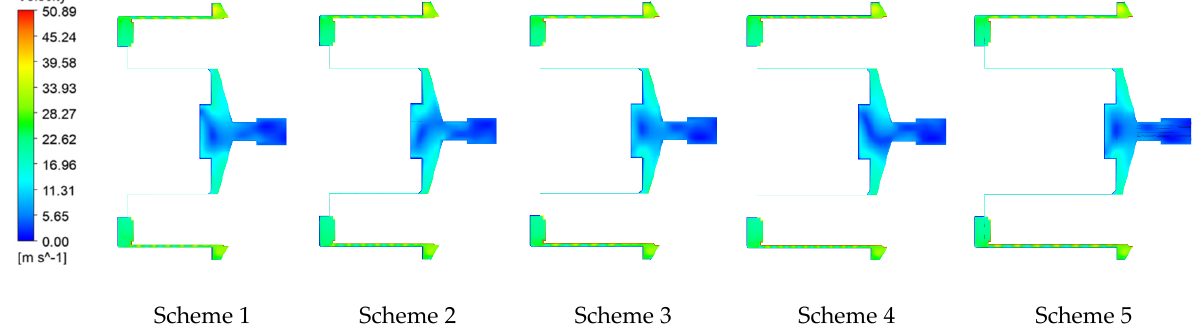
Figure 16. Comparison of velocity distribution of different schemes.